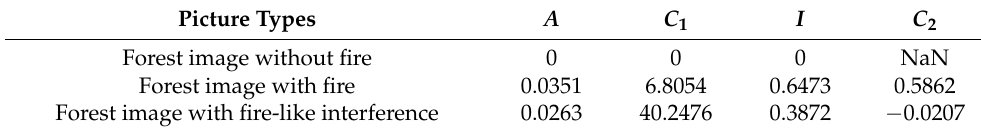
Table 2. Gray level co-occurrence matrix feature